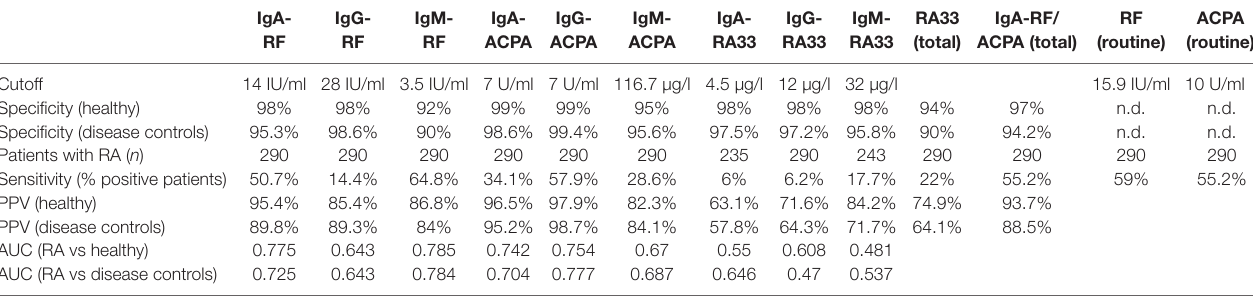
TaBle 2 | Specificity and sensitivity of rheumatoid factor (RF), anti-citrullinated protein antibodies (ACPA), and RA33 isotypes for the diagnosis of rheumatoid arthritis